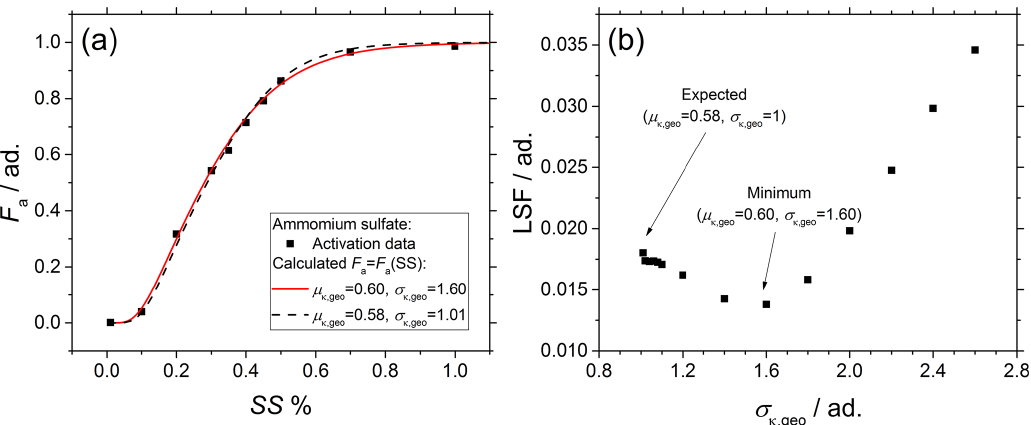
Figure A1. Sensitivity analysis performed on ammonium sulfate particles. (a) Comparison of F a = F a ( SS ) calculated from the same aerosol size distribution with σ κ, geo = 1 . 01 (dashed black line) or alternatively σ κ, geo = 1 . 6 (solid red line). (b) LSF = LSF( σ κ, geo